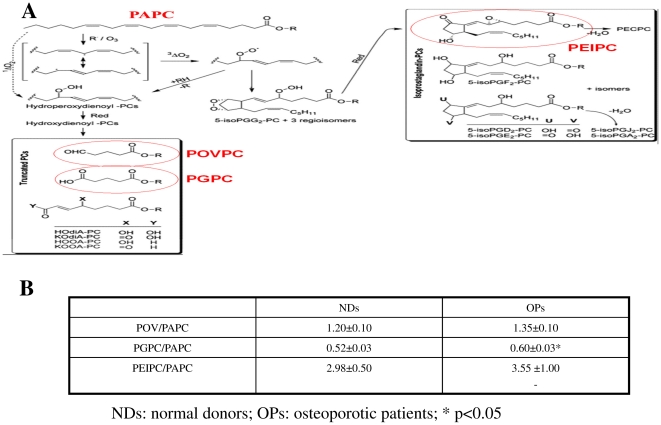
Ox-PAPCs in peripheral blood.A) Representation of autoxidised reaction of 1-palmitoyl-2-arachidonoyl-sn-glycero-3-phosphocholine. B) Levels of POVPC, PGPC and PEIPC (ox-PAPCs) in sera of normal donors (NDs) and osteoporotic patients (OPs). PGPC form resulted significantly higher in osteoporotic patients with respect to normal donors (p<0.05).